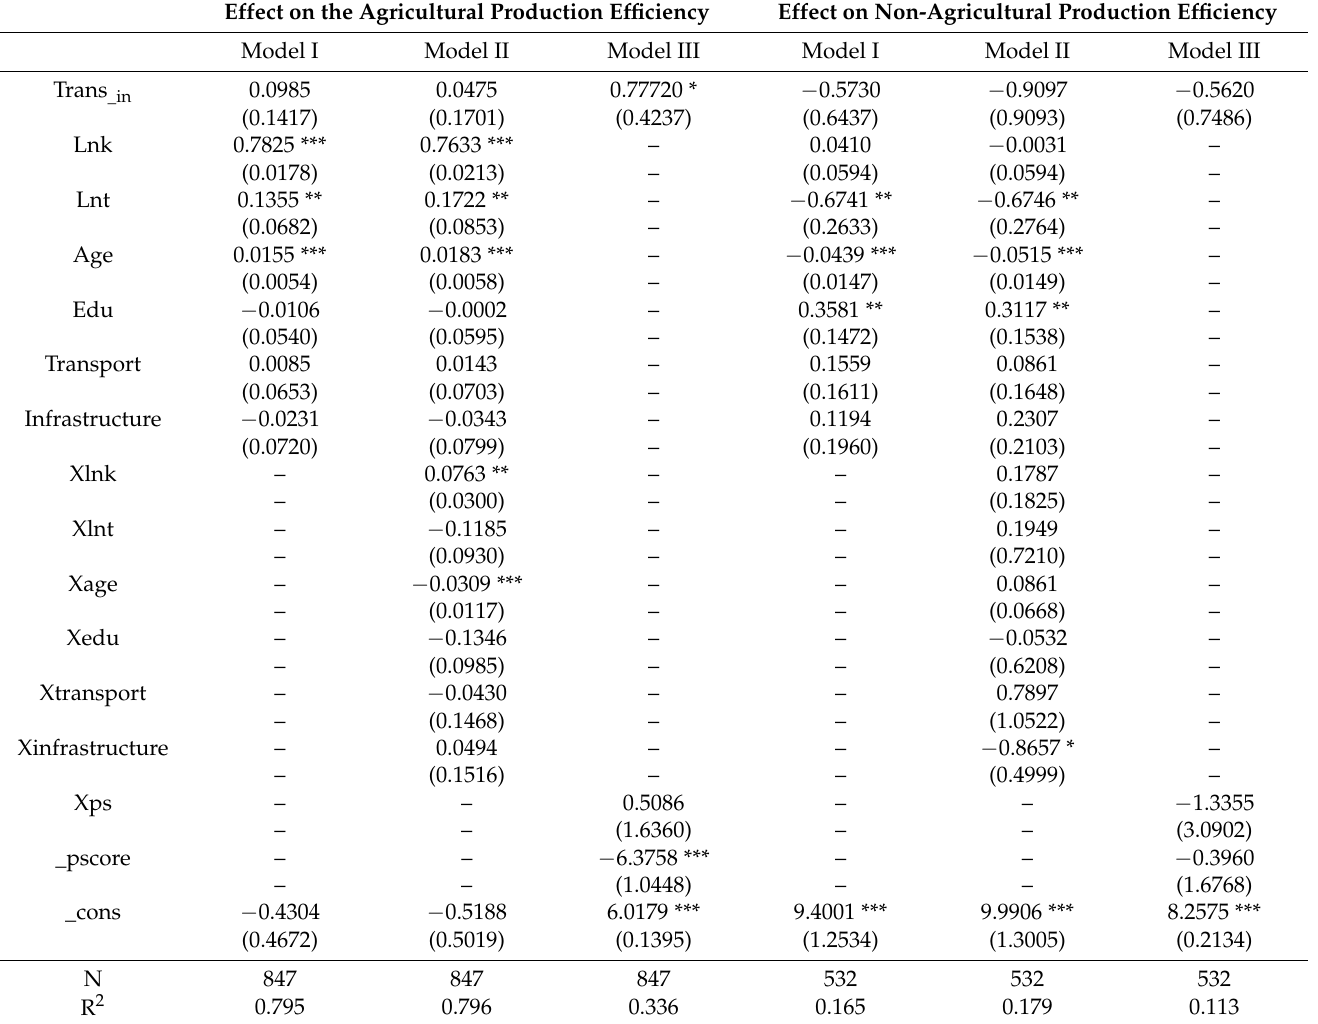
Table 8. Effect of Land transfer-in on Different Kinds of Labor Productivity of Farmer Households. Effect on the Agricultural Production